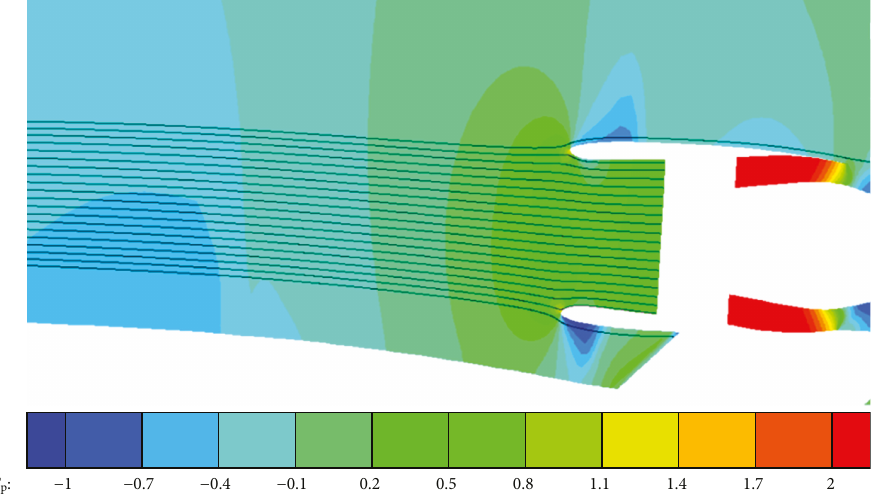
Figure 15: In fl ow streamlines of the engine on its symmetry plane at the cruise